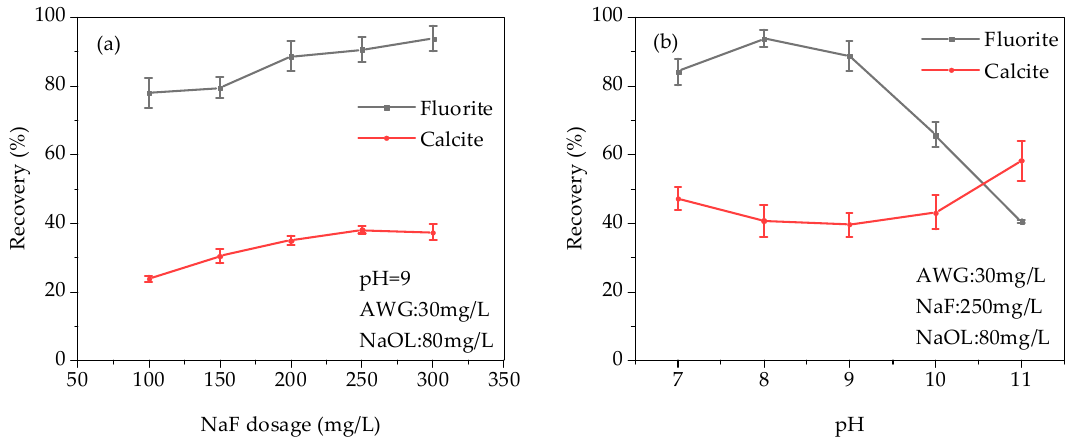
Figure 3. Effect of ( a ) dosage of NaF and ( b ) pH value on the recovery of fluorite and calcite. To verify the effect of the fluoride ion on the flotation separation of fluorite and calcite with AWG as a depressant, the flotation tests of inhibiting calcite and collecting fluorite were designed for the artificial mixed ore. The experimental conditions were as follows: pH = 9, AWG (30 mg/L) as depressant, NaOL (250 mg/L) as collector, and NaF (80 mg/L) as auxiliary reagent. The mixture was passed through a roughing stage to obtain fluorite concentrate. The experimental results are shown in Tables 1 and 2. After adding NaF, the grade of fluorite in the concentrate increased from 35.26% to 61.08%, and the grade of calcite decreased from 64.74% to 38.92%, indicating that the addition of a fluoride ion can significantly improve the flotation separation effect of fluorite and calcite.